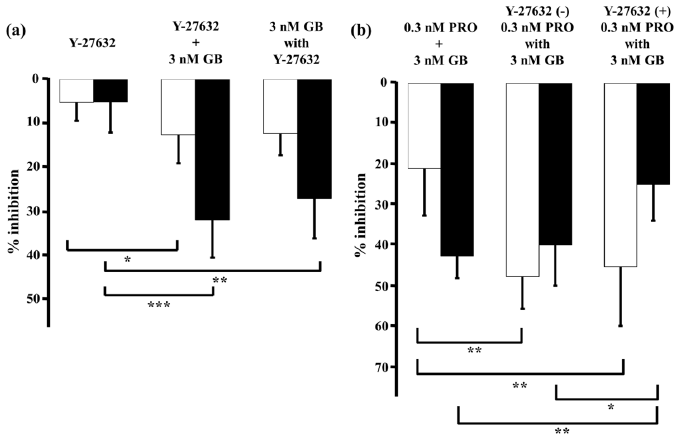
Figure 8. Y-27632-induced Ca 2+ sensitization is not involved in synergy between β 2 -adrenoceptor agonists and muscarinic receptor antagonists. In each panel, percent inhibition of tension is represented by white columns, and F340/F380 is represented by black columns. ( a ) Left , percent inhibition of tension and F340/F380 with Y-27632 (1 μ M); Center , sum of percent inhibition of tension and F340/F380 with Y-27632 (1 μ M) and glycopyrronium (3 nM); Right , percent inhibition of tension and F340/F380 with combination of Y-27632 (1 μ M) and glycopyrronium (3 nM); ( b ) Left , sum of percent inhibition of tension and F340/F380 with procaterol (0.3 nM) and glycopyrronium (3 nM); Center , percent inhibition of tension and F340/F380 with combination of procaterol (0.3 nM) and glycopyrronium (3 nM); Right , percent inhibition of tension and F340/F380 with combination of procaterol (0.3 nM) and glycopyrronium (3 nM) in the presence of Y-27632 (1 μ M). GB, glycopyrronium bromide; PRO, procaterol; MCh, methacholine. *** p < 0.001; ** p < 0.01; * p < 0.05.